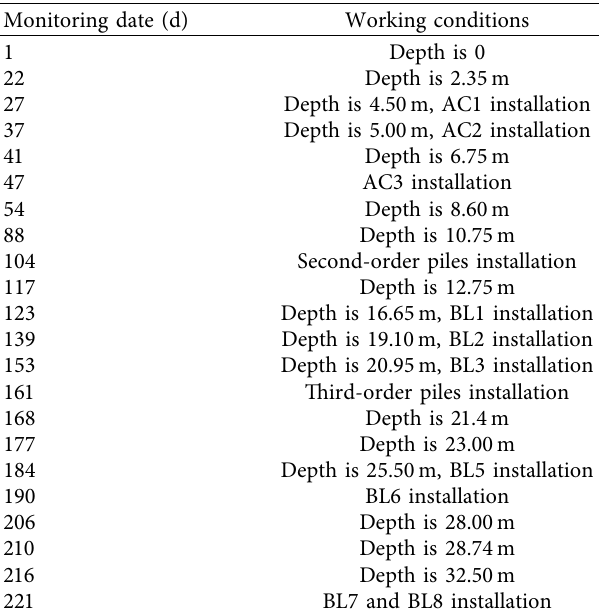
Figure 4: Schematic diagram of test pile installation process. (a) Drilling the holes. (b) Test pile lifting. Table 2: Monitoring date and working